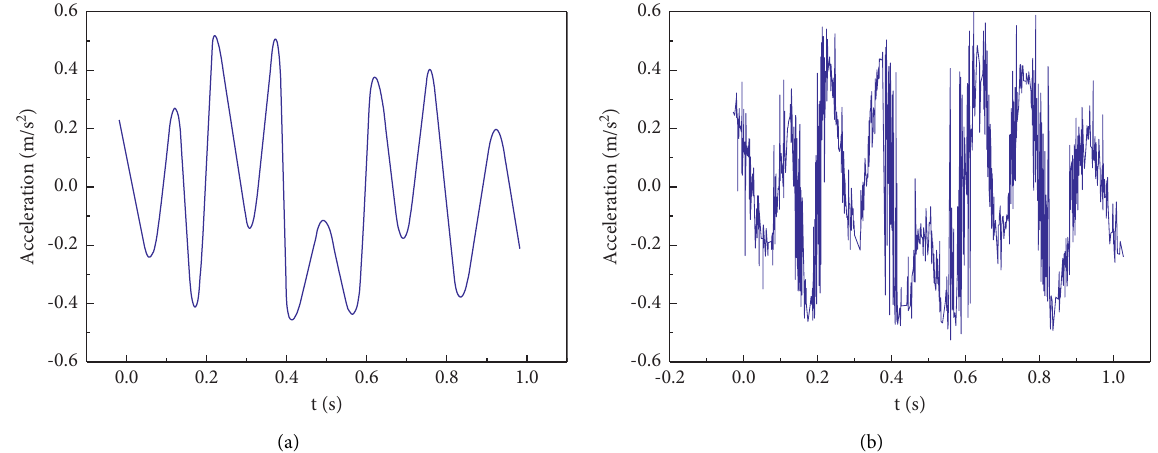
Figure 4: Simulated building vibration signal without and with noise.